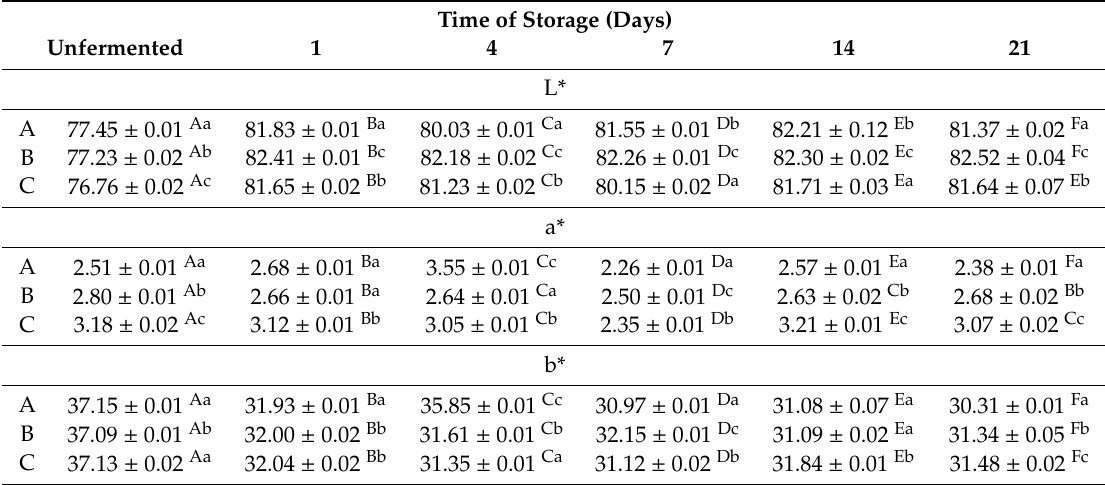
Table 4. Color values of fermented beverages and unfermented (control) samples.